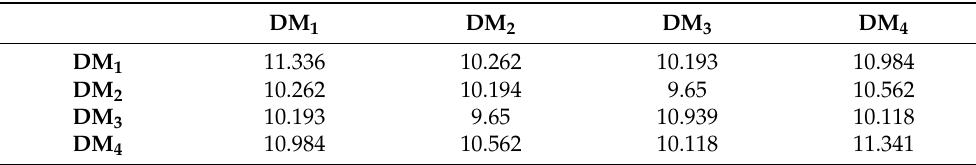
Table 3. Correlation measures of neutrosophic pair for each decision-maker.